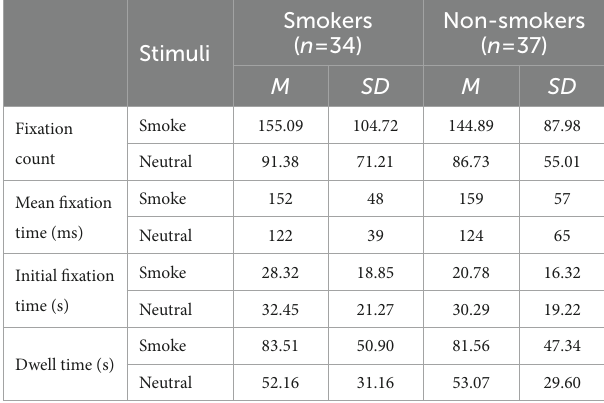
TABLE 1 Descriptive results of eye tracking during the